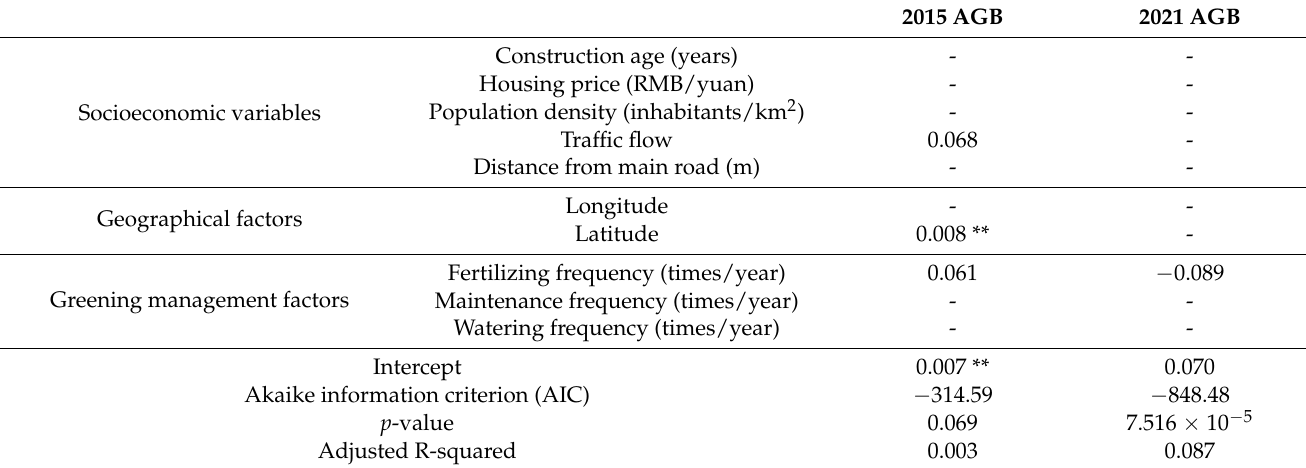
Table 3. Stepwise regression models with factors predicting the change of above ground biomass (AGB) from 2015 to